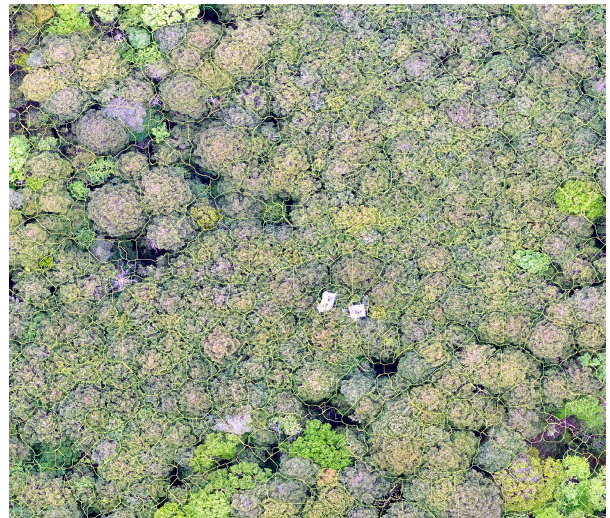
Figure 7. Results of the watershed segmentation method for delineating the individual canopy area.